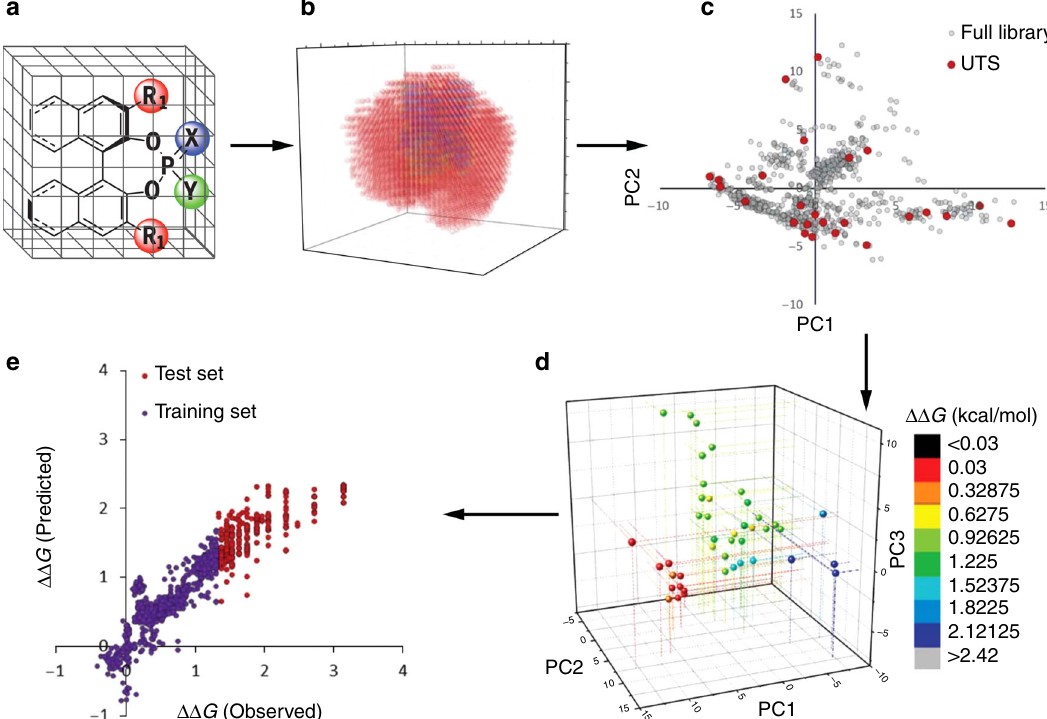
Fig. 3 Steps for an application of chemoinformatics in organocatalyst design. a An in silico library of catalyst candidates is generated. b Relevant chemical descriptors are calculated. c A universal training set (UTS) is selected. d Experimental selectivity data are collected. e Machine learning predicts high-selectivity reactions using moderate-to-low-selectivity reactions. The fi gure content is reproduced with permission from AAAS 18